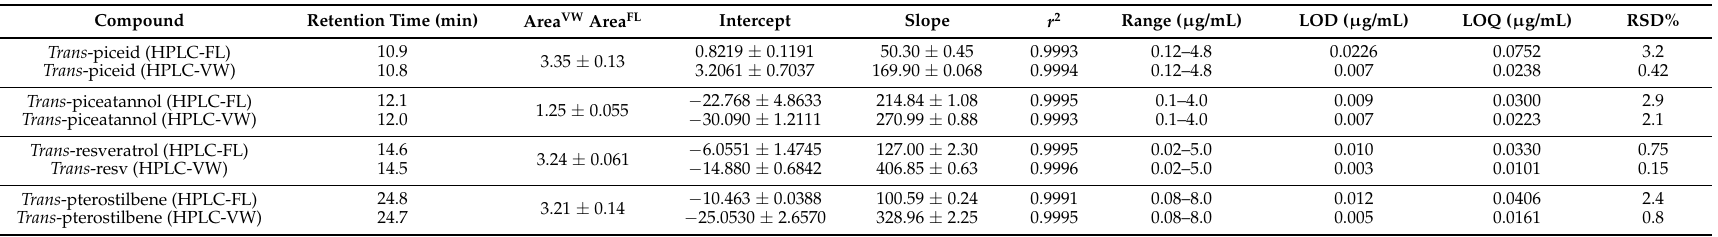
Table 1. Retention times, relationship between areas, linearity parameters, detection and quantification limits (LOD, LOQ) and repeatability of the High Performance Liquid Chromatography (HPLC) system for